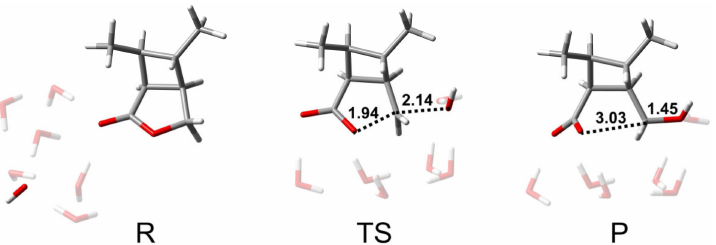
Figure 3. Structures of R, TS, and P of B AL 2 reaction path of CBL with 6 H 2 O molecules. The unit of distance is